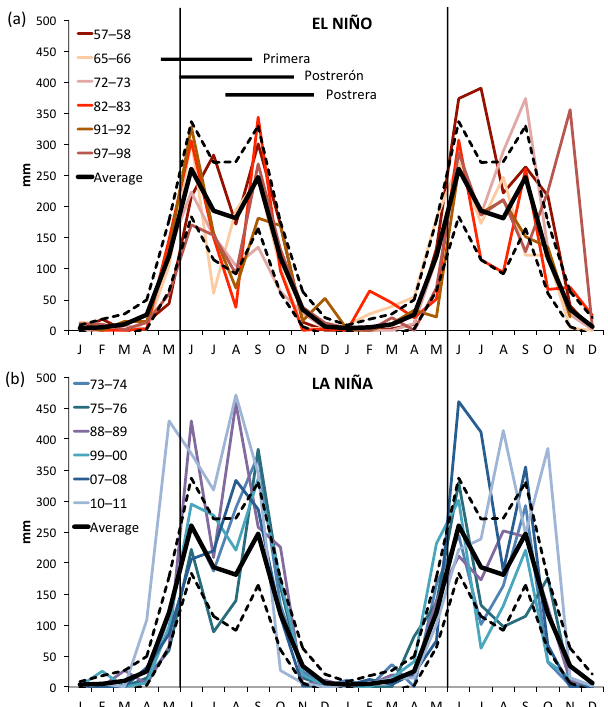
Figure 2. Average monthly precipitation for Guatemala City Ob- servatory (INSIVUMEH) between 1960 and 1990 (black, panel a ) compared to individual precipitation records for the six strongest El Niños (57–58, 65–66, 72–73, 82–83, 97–98) and (b) compared to the six strongest La Niñas (73–74, 75–76, 88–89, 99–00, 07–08, 10–11) of the 20th century in the Oceanic Niño Index (ONI; NOAA Climate Prediction Center; CPC). Vertical lines mark the usual start and end of an El Niño–Southern Oscillation (ENSO; May–June) year, peaking in boreal autumn and winter (Curtis, 2002). Horizon- tal lines indicate the three time frames of modern crop production in Central America (Arias et al., 2012). The first, second and third crop seasons are indicated by the terms “primera”, “prostrerón” and “postrera” respectively. Dashed lines indicate 1 standard deviation with respect to the average monthly precipitation of the 1960–1990